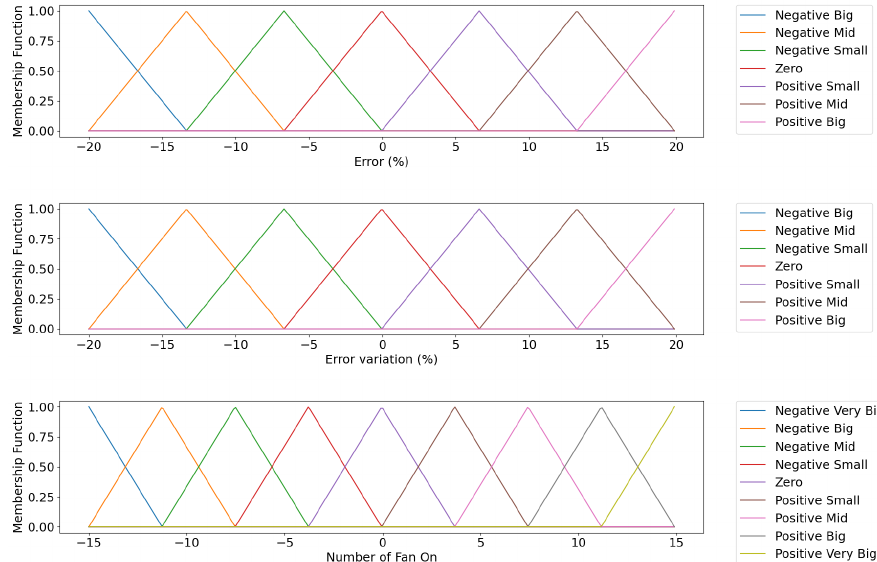
Figure 13. Fuzzy fan optimizer controller sets.